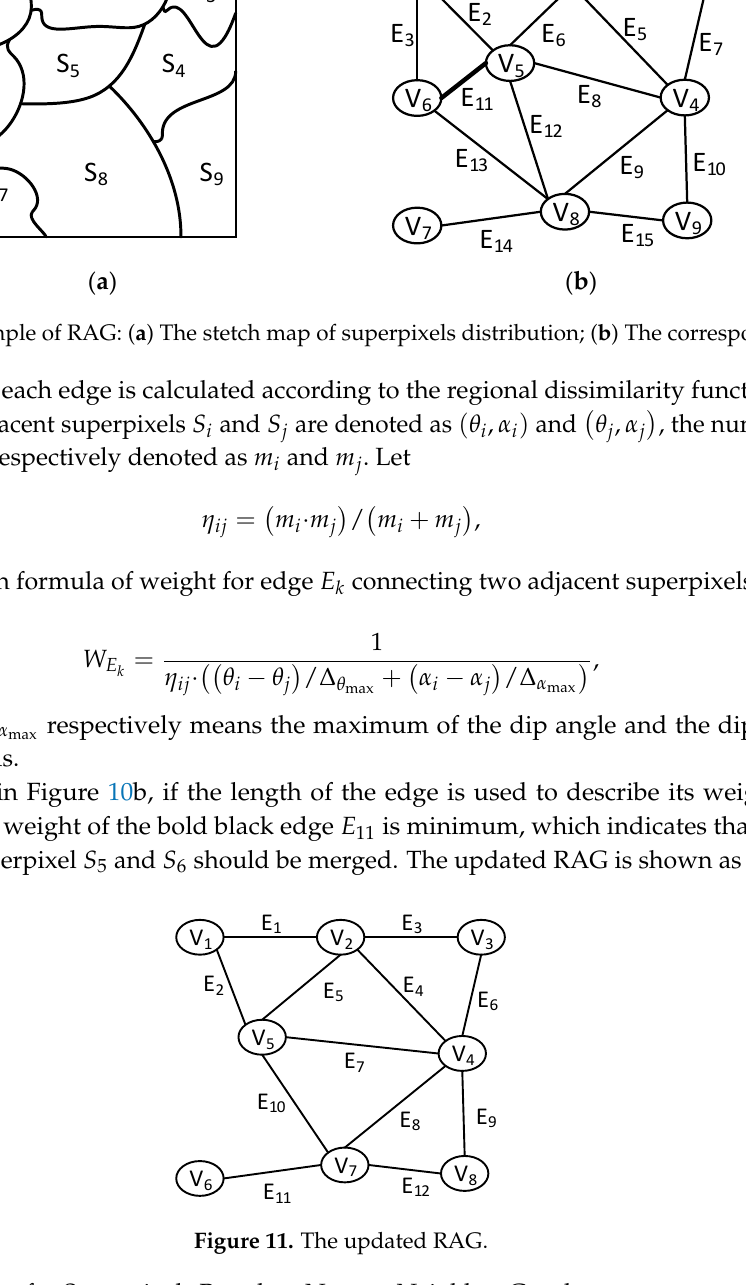
14 of 26 Figure 9. An example of superpixel segmentation for an image: ( a ) Overlay display of the origin image and the corresponding superpixel segmentation result; ( b ) The RAG corresponding to superpixels. The RAG of the superpixel set (cid:4668)𝑆 (cid:2869) , 𝑆 (cid:2870) , ⋯ , 𝑆 (cid:3041) (cid:4669) could be described by nodes and edges. Each node represents a superpixel, and each edge connects two adjacent superpixels. An example of RAG